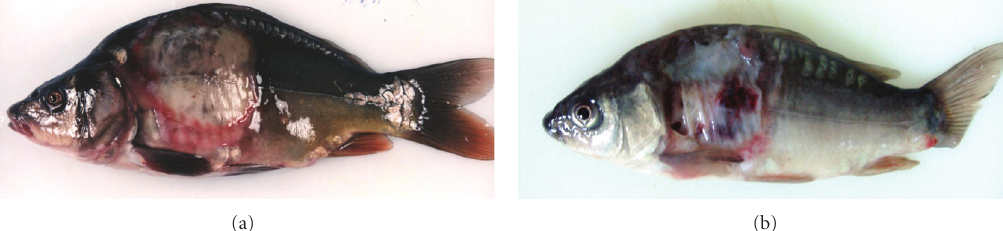
Figure 3: Extensive dermatitis in carp Sc challenged with A. veronii bt. sobria strains Pt 57 (a) and K48 (b). Distended anus (arrow) was the first symptom of septicaemia.